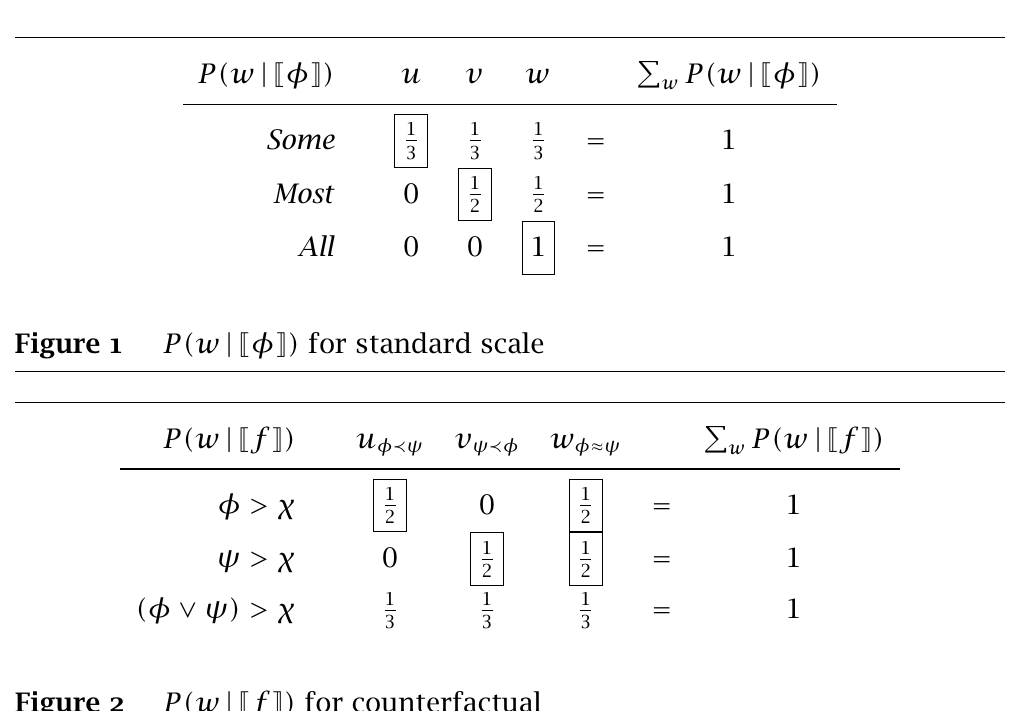
Figure 2 P(w | (cid:130)f (cid:131)) for